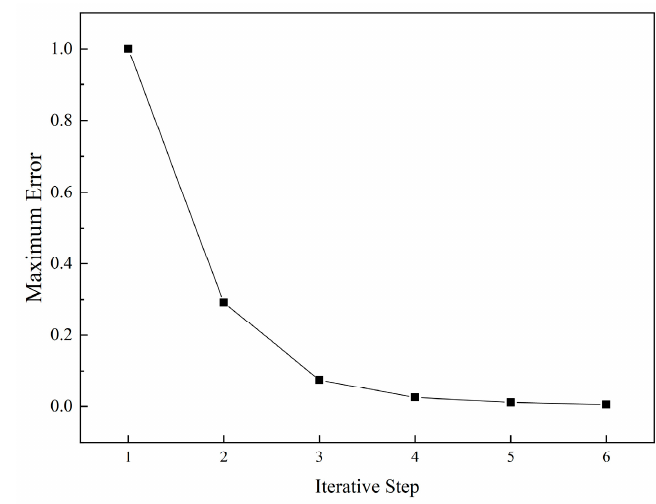
Figure 7. Iterative convergence of the PSEFF method.